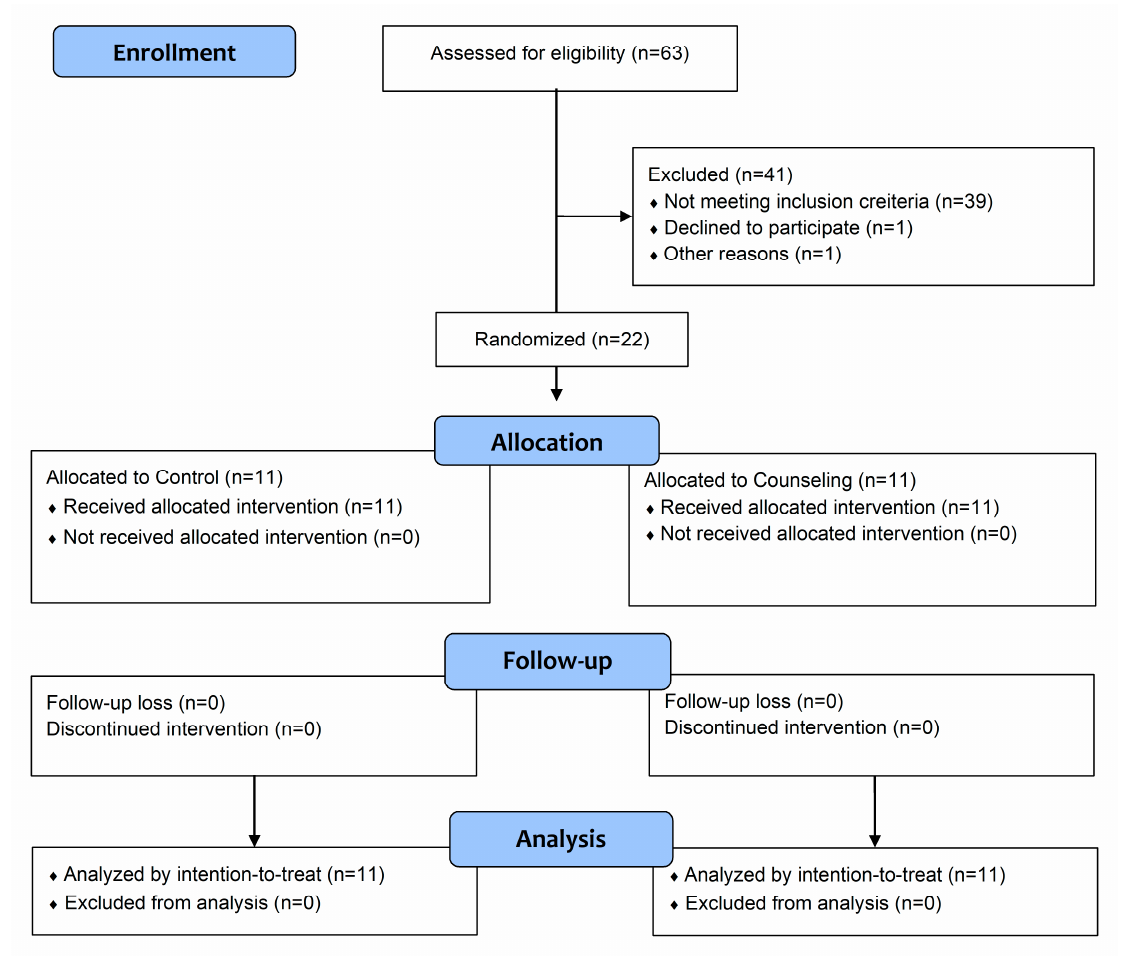
Figure 1. Flow diagram of the Figure 1 . Flow diagram of the study.